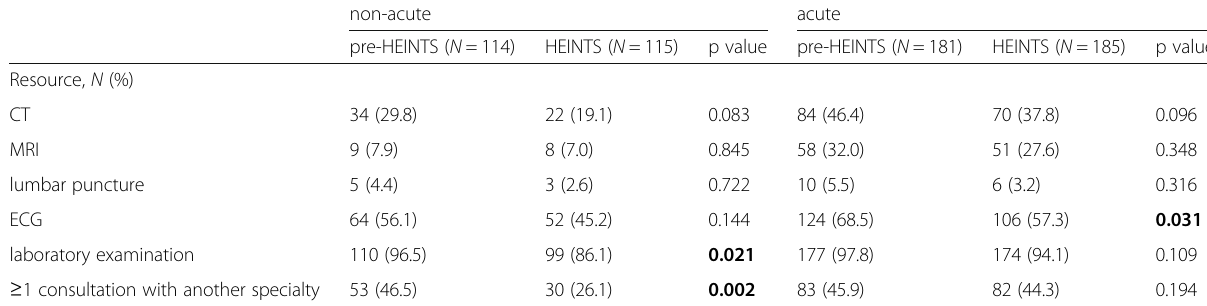
Table 3 Resource utilization in acute and non-acute patients in pre-HEINTS and HEINTS groups non-acute acute pre-HEINTS ( N = 114) HEINTS ( N = 115) Resource, N